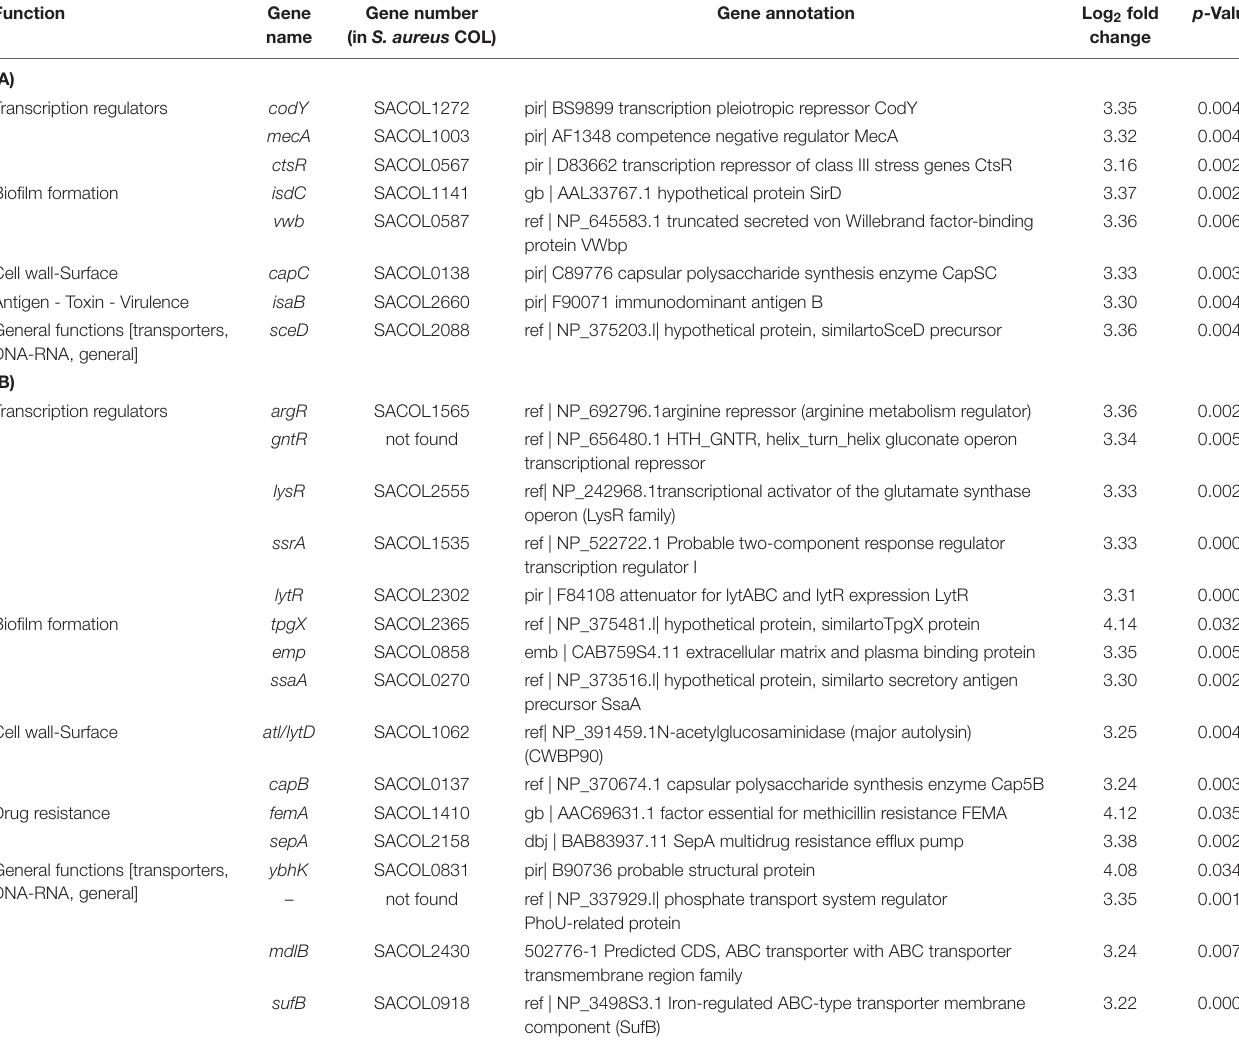
TABLE 1 | Significantly upregulated genes at pH 9 in S. aureus COL biofilm-associated (A) and planktonic cells (B) ( p < 0.05).